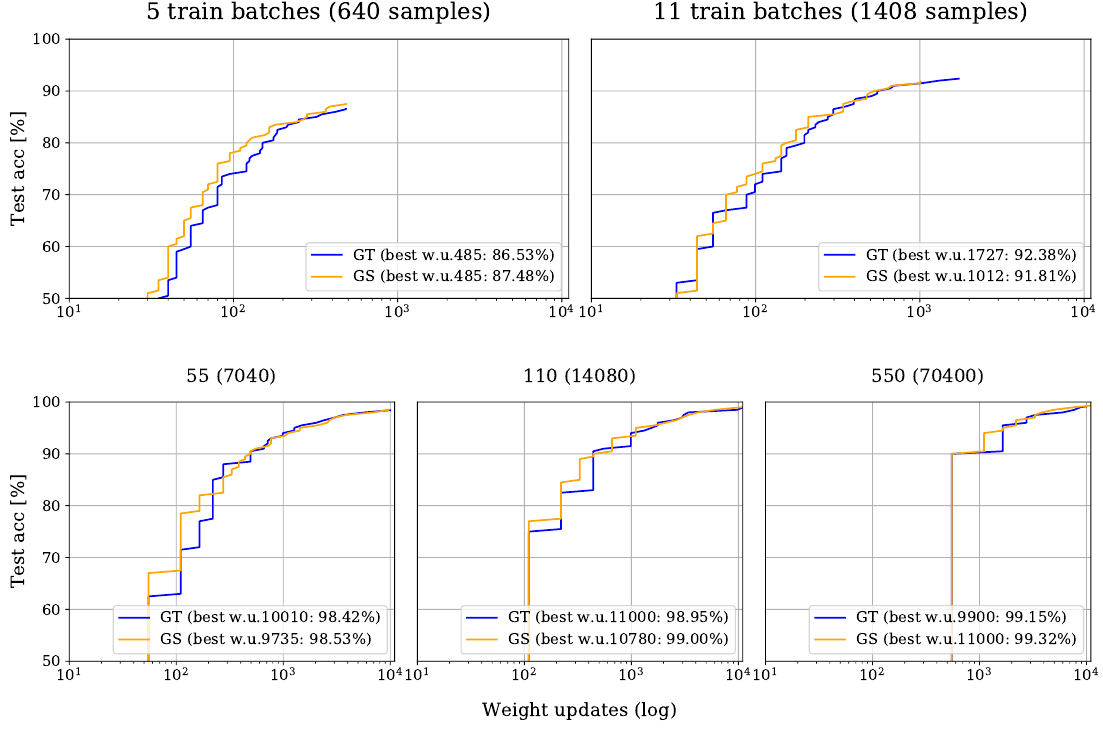
Figure 8. CNN performance milestone reached over number of weight updates—GoodSounds data. Figure notation: Test acc—Accuracy performance metric measured on the testing set. Best w.u.—Weight update after which the highest performance was